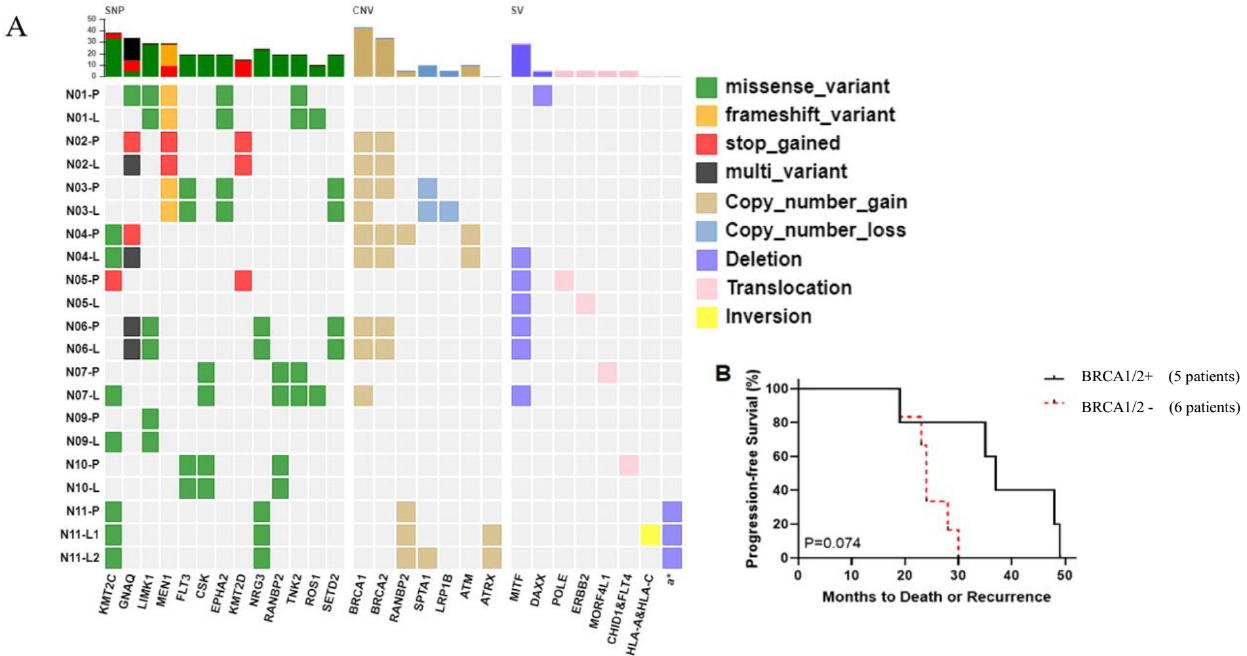
Figure 2. The mutational landscape in paired primary PanNETs and liver metastases. ( A ) Potential driver alterations identified in paired primary PanNETs and liver metastases, a*: HLA − B & HLA − C & RPL3P2 & USP8P1 & WASF5P & XXbac-BPG248L24.10 & XXbac-BPG248L24.12 & XXbac-BPG248L24.13. ( B ) The Kaplan–Meier curve of PFS of the study patients stratified by positive ( n = 5) or negative ( n = 6) BRCA1/2 CNV. The p value was calculated by the log-rank